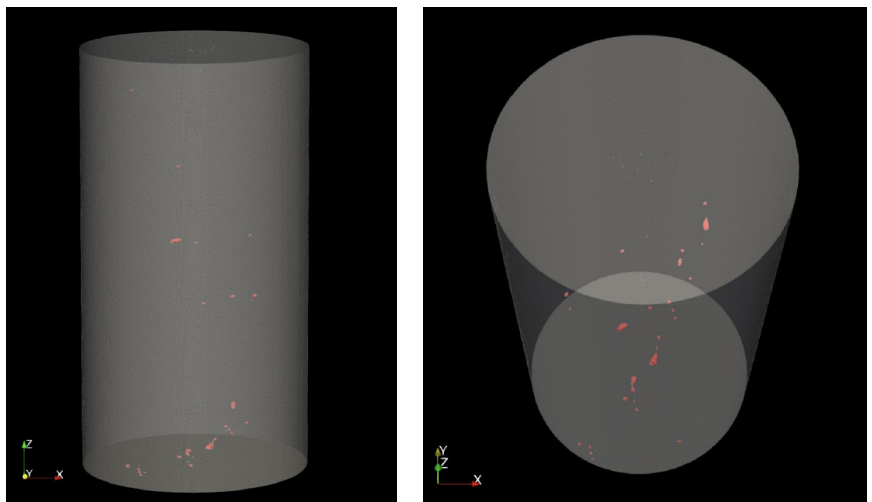
Figure 5. Micro-CT 3D reconstruction (18 µm/voxel) of specimen. Cylinder specimen dimensions: 20 mm × 10 mm (length × diameter), red volumes indicate manufacturing defects identified as porosity. X direction represents the longitudinal bead layering direction, Y represents the transverse bead direction.